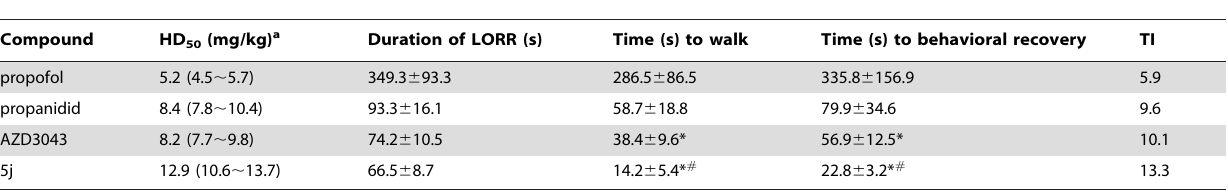
Table 2. Hypnotic potency of propofol, propanidid and 5j in rat.